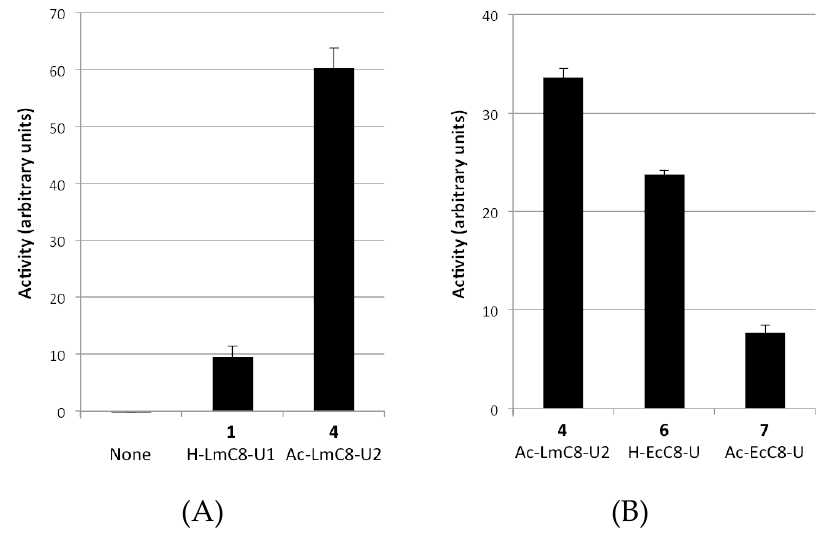
Figure 1. Activation of LmHslV by HslU-derived peptides. ( A ) Activation of LmHslV by peptides corresponding to the 8 C-terminal residues of LmHslU1 (compound 1 ) and U2 (compound 4 ). LmHslV (300 nM) was incubated at 37 °C with the peptide substrate Z-GGL-AMC (100 μ M) in the presence of vehicle (left) or 2.2 mM of the peptides H-LmC8-U1 or Ac-LmC8-U2. The fluorescence of the free AMC group liberated by hydrolysis of the substrate, which is proportional to the proteolytic activity of the sample, was measured every 15 min for 2 h. The activity is calculated as fluorescence units liberated by the minute during the linear period of the assay. The values are the mean of two experimental replicates for a representative experiment; errors bars represent deviation from the mean of the values. ( B ) LmHslV can also be activated by octapeptides derived from the C-terminus of HslV from E. coli . Assays were performed as in ( A ), using compounds 4 (Ac-LmC8-U2), 6 (H-EcC8-U) and 7 (Ac-EcC8-U).